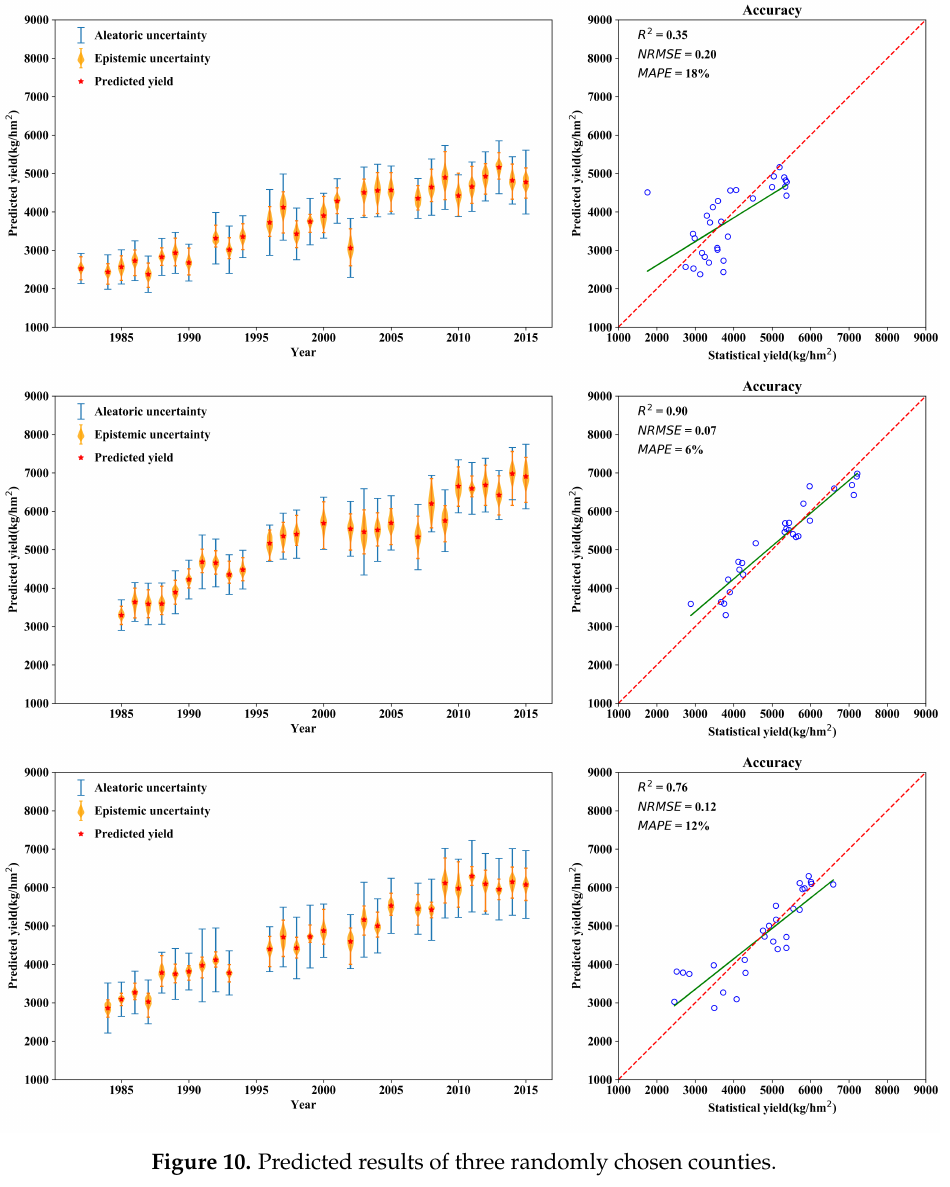
Figure 10. Predicted results of three randomly chosen